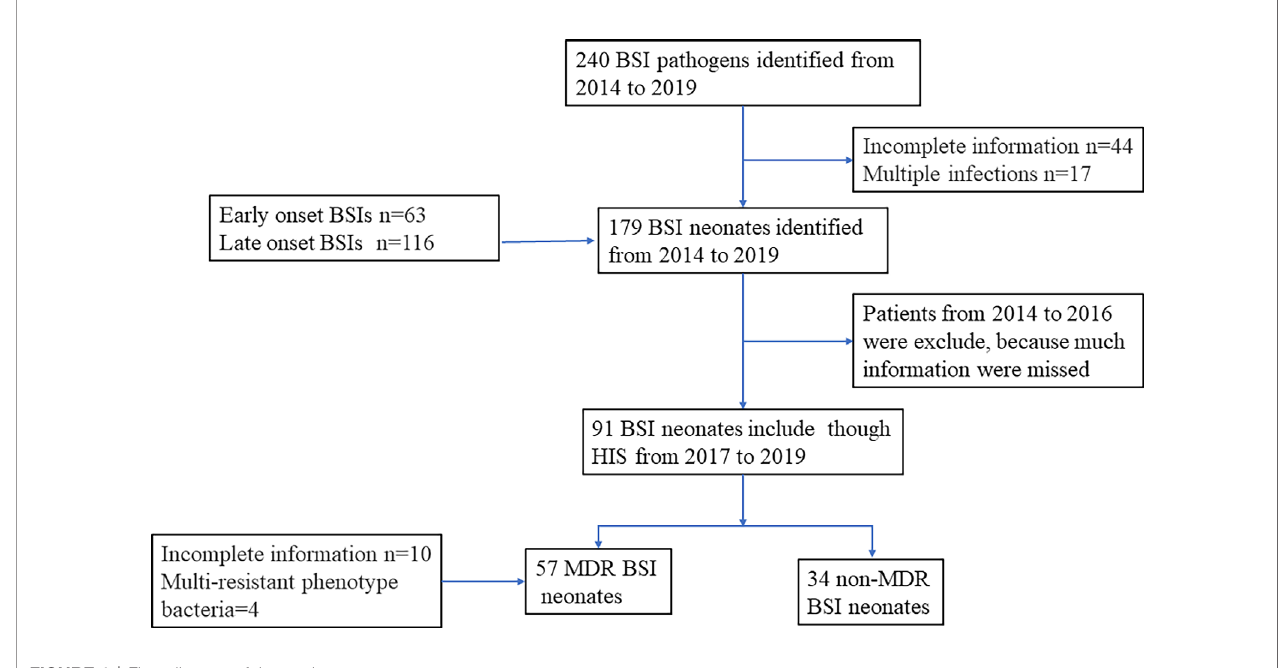
FIGURE 1 | Flow diagram of the study process.